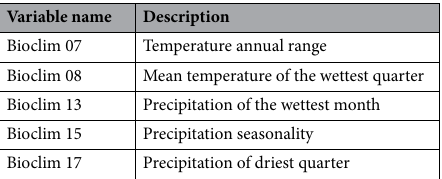
Table 1. Variables selected by the PCA for the S. exempta environmental suitability